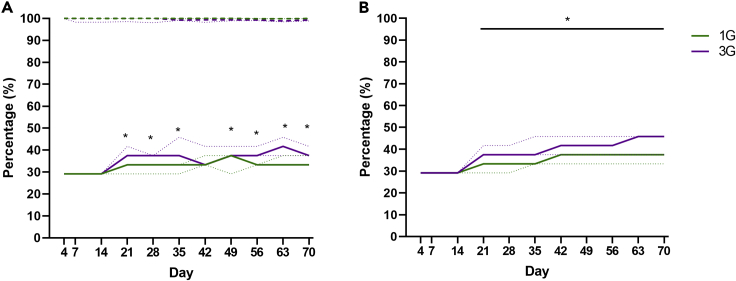
Representation and relative abundance of donor bacterial taxa and in mice receiving material from antibiotic-disrupted mice(A) Percentage of donor taxa represented in recipient germ-free mice that received one (1G) or three (3G) rounds or fecal gavage of the antibiotic-disrupted microbiota (solid line). The total relative abundance of donor taxa in the recipient mice at each time points were determined (dashed line).(B) The cumulative detection of donor bacterial taxa in recipient mice were determined. Solid or dashed lines denote median values, while the dotted lines denote interquartile ranges. Statistical comparison between groups were performed using the Mann-Whitney test at a level of p < 0.05 for significance.